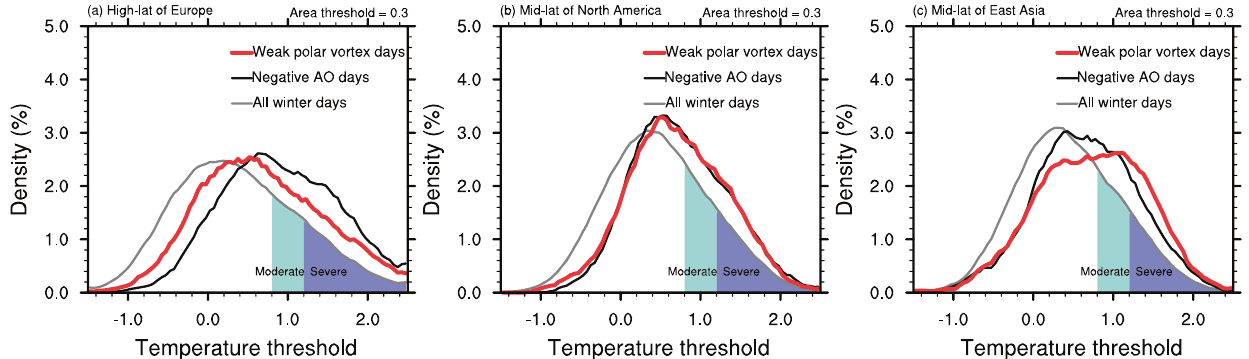
Fig. 3 Comparisons between the effects of the weak polar vortex and the negative AO on CAOs. a The frequency distribution of CAOs as a function of the temperature threshold used to de fi ne CAOs under all winter days (in gray), under weak polar vortex days (in red), and under negative AO days (in black) for the reanalysis dataset. b , c As shown in ( a ), but for mid-latitudes of North America and East Asia, respectively. Cyan and blue shading respectively indicate the range of thresholds used to de fi ne the moderate and